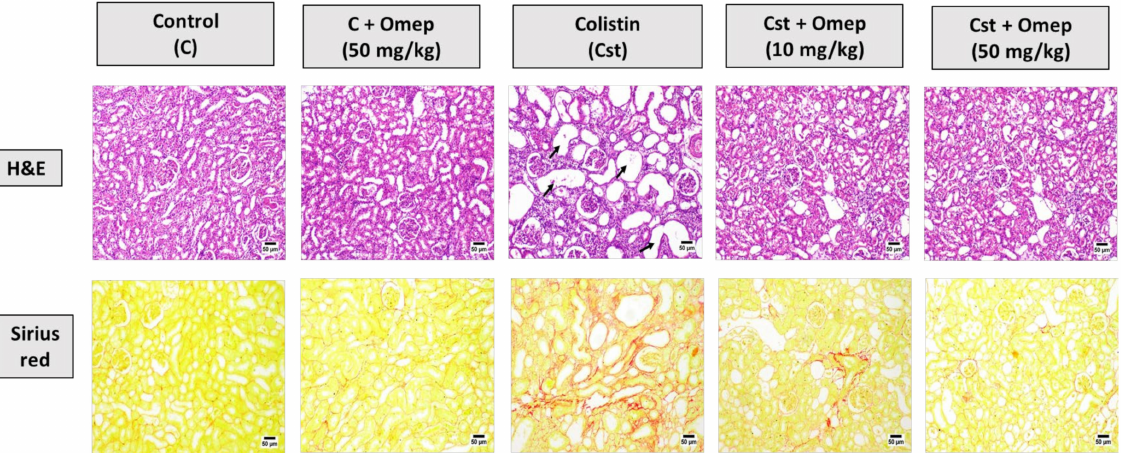
Figure 2. Effects of omeprazole on colistin-induced kidney injury as visualized using H&E (upper plates) and Sirius red staining (lower plates). Black arrows indicate diffuse interstitial nephritis, Red coloration in the Sirius red-stained sections indicates collagen